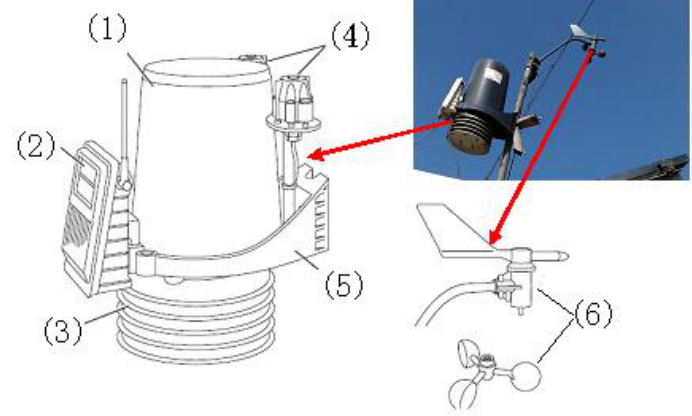
Figure 6. Meteorological sensor module: ( 1 ) rain collector, ( 2 ) solar panel, ( 3 ) radiation shield, ( 4 ) sensors mounting shelf, and ( 5 ) module base.